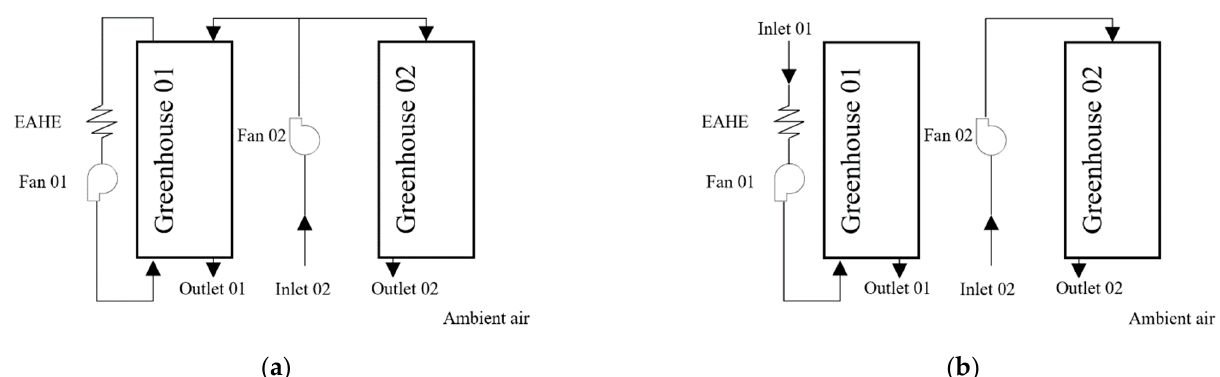
Figure 1. Layouts of GH + EAHE with the reference GH. ( a ) Closed-loop schematics. ( b ) Open-loop schematics.